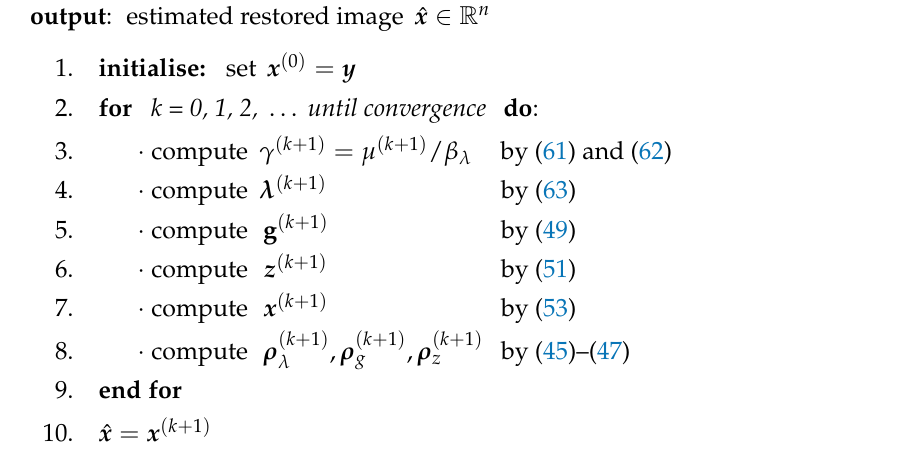
Algorithm 1: General DP-ADMM approach for image restoration variational models of the TV-KL form in (8) and (9) and automatic selection of µ via